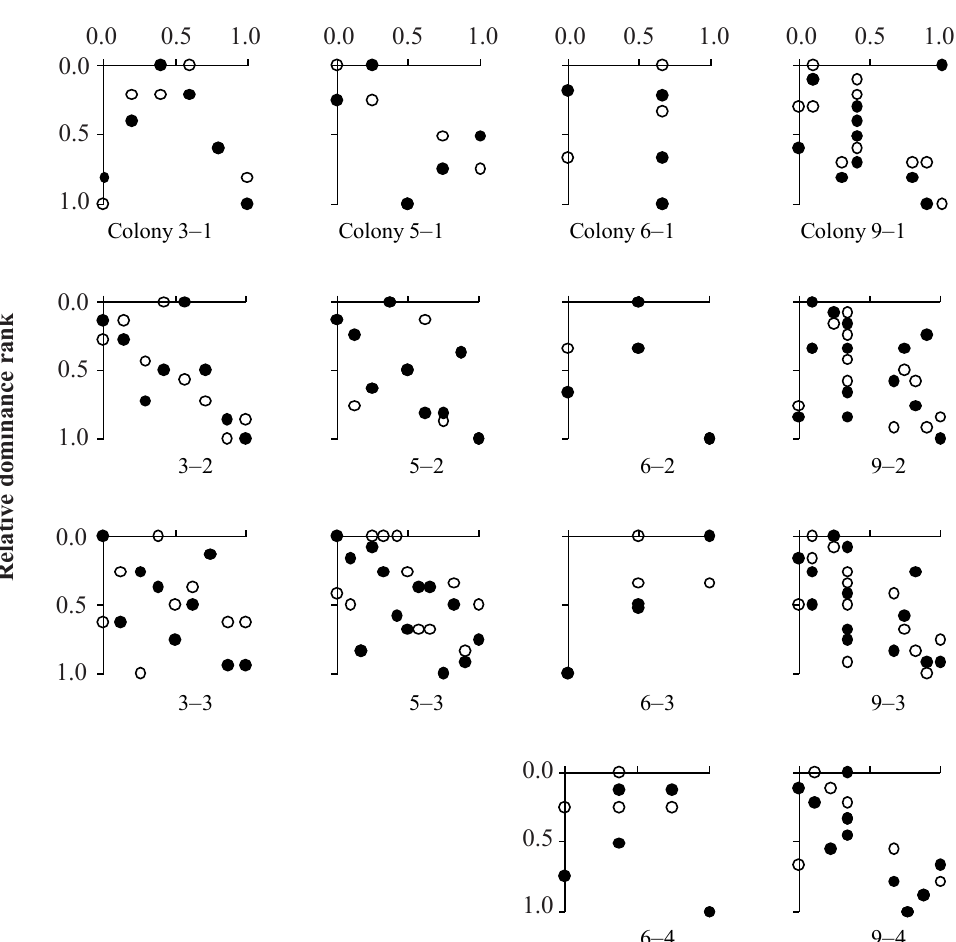
Fig 2. Relationship between the dominance rank and the emergence order. The dominance rank was based on the dominance index (DI, solid) and standings (open). The dominance rank and emergence order are expressed according to the relative rank or order: the first and last ones are indicated by 0 and 1, respectively. The queen was designated by a relative emergence order of